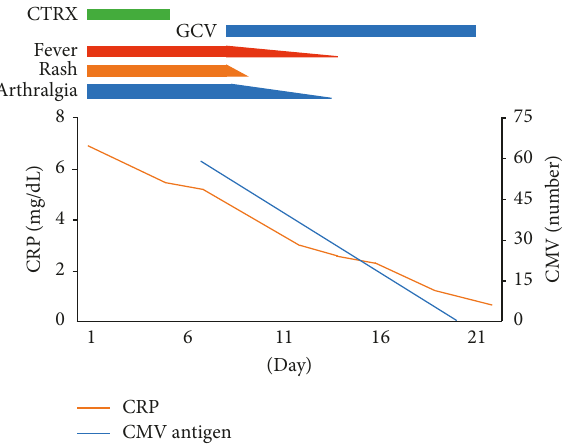
Figure 2: Clinical course of this case. CTRX: ceftriaxone; GCV: ganciclovir; CRP: C-reactive protein; CMV: